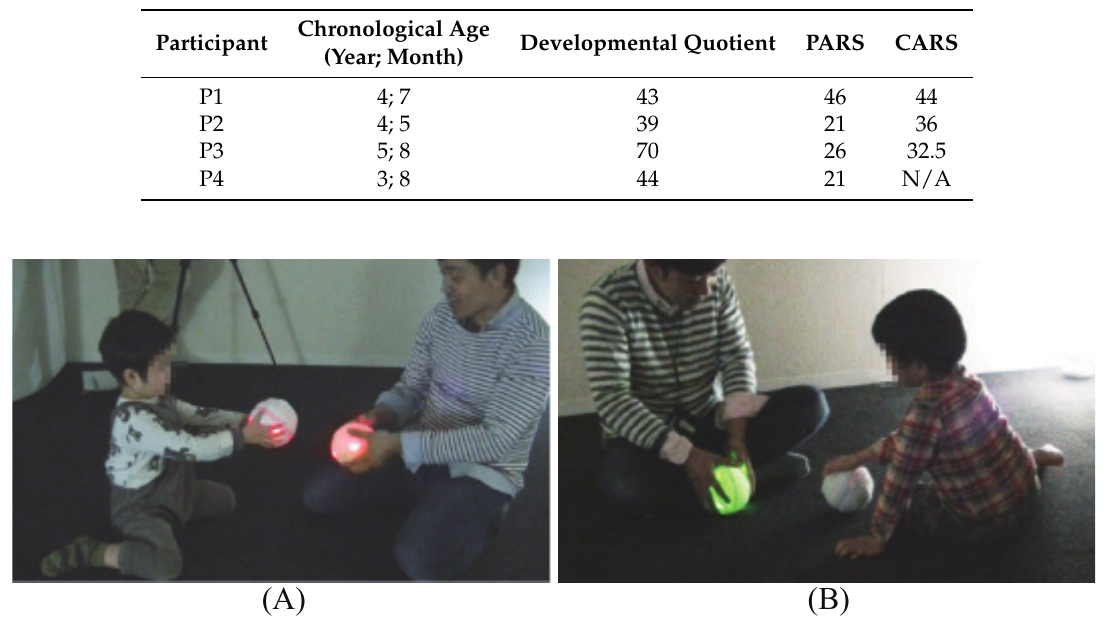
Figure 4. ( A ) Participant during a session with the Two-sided lighting rule, ( B ) Participant during a session with the One-sided lighting